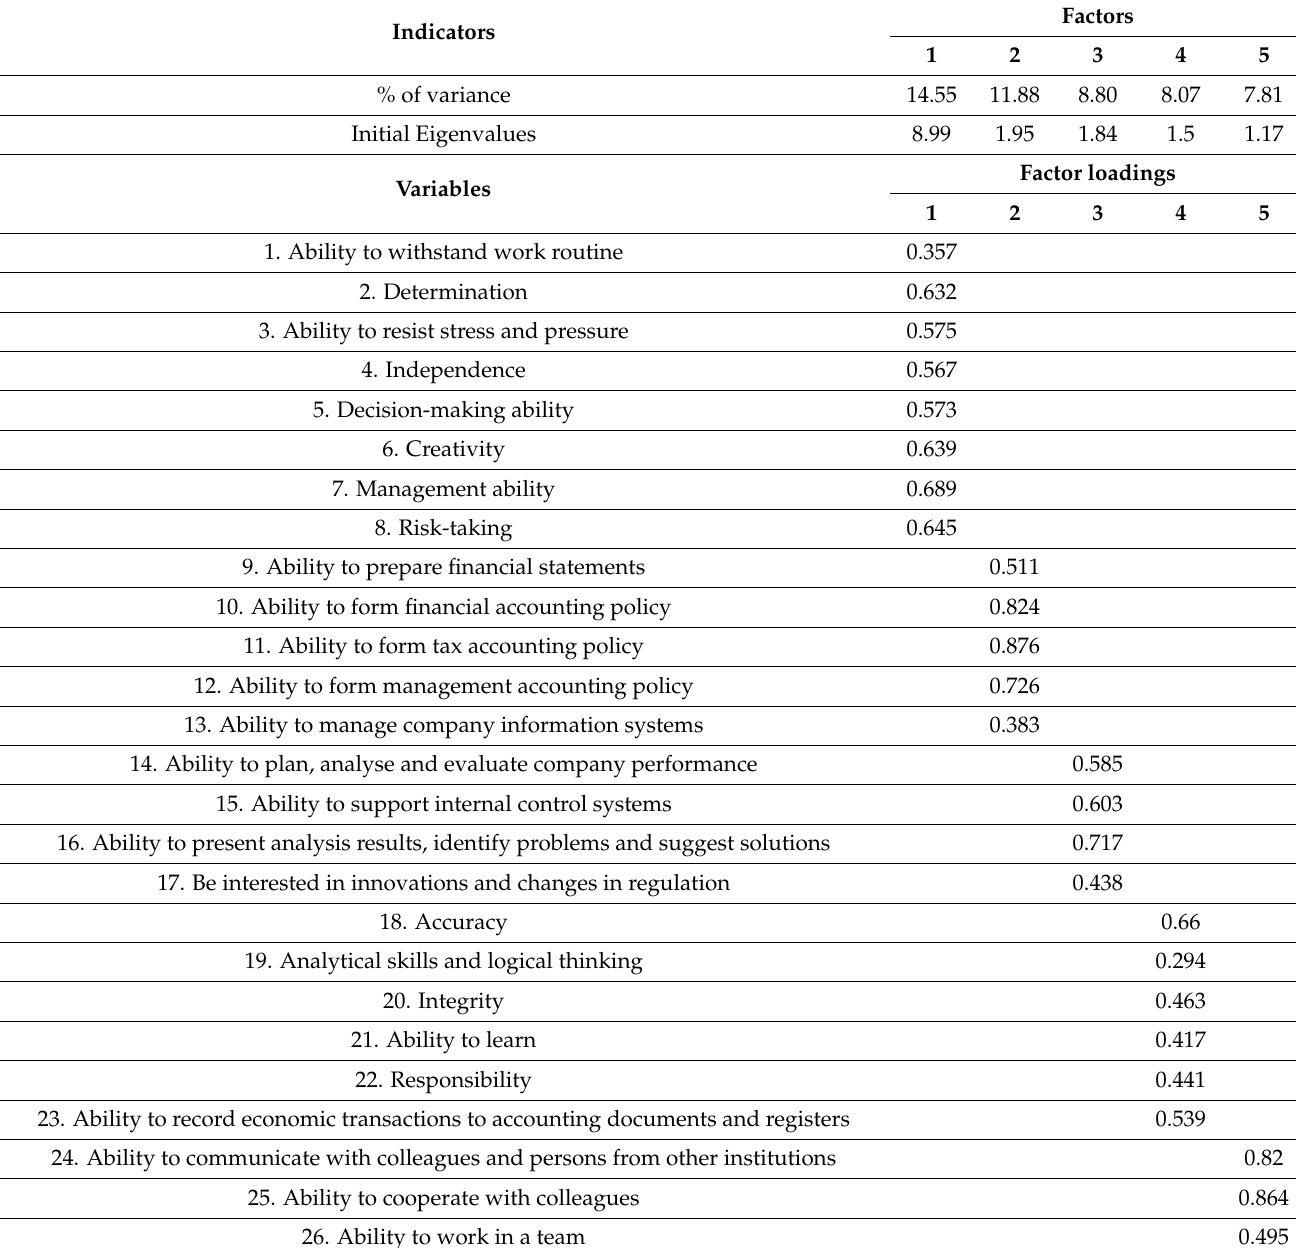
Table 6. Factors of Competencies of Modern Accounting